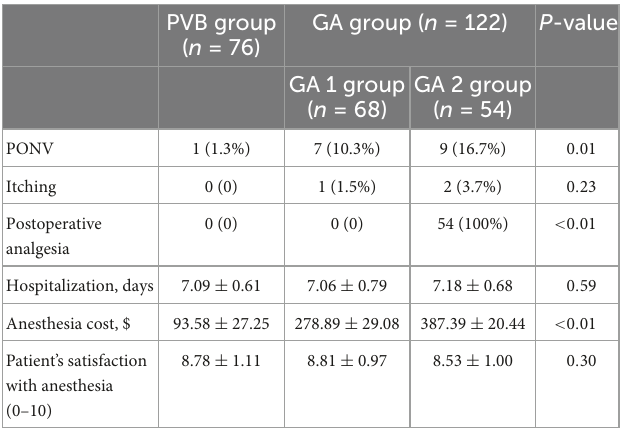
TABLE 4 Postoperative complications and other related indicators.